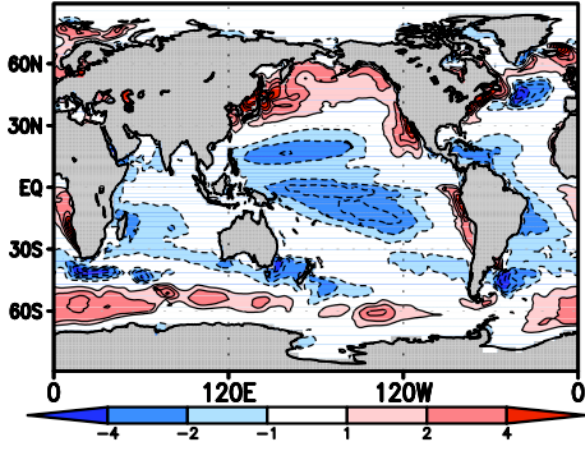
Fig. 4. The global annual mean sea surface temperature representa- tion ( ◦ C) of PI in comparison with World Ocean Atlas SST (WOA, Figure 4. The global annual mean sea surface temperature representation (°C) of PI in 3 comparison with World Ocean Atlas SST (WOA, 2009). 4